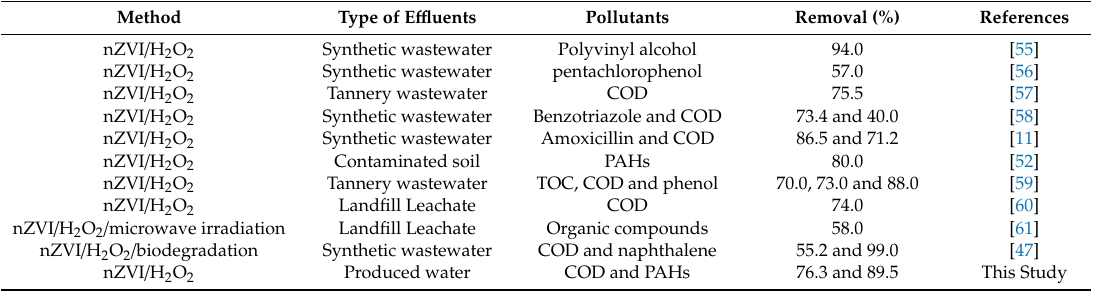
Table 4. Comparison of previously conducted heterogeneous Fenton like oxidation studies with the current